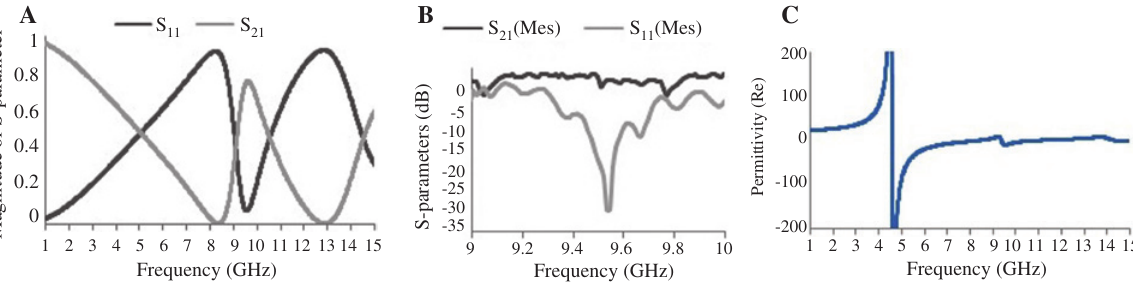
Figure 3: (A) Amplitude of S-parameters (reflection and transmission parameter) for the proposed unit cell structure, (B) measured S-parameters (S and S ), and (C) real value of effective permittivity versus frequency for z -axis wave 11 21